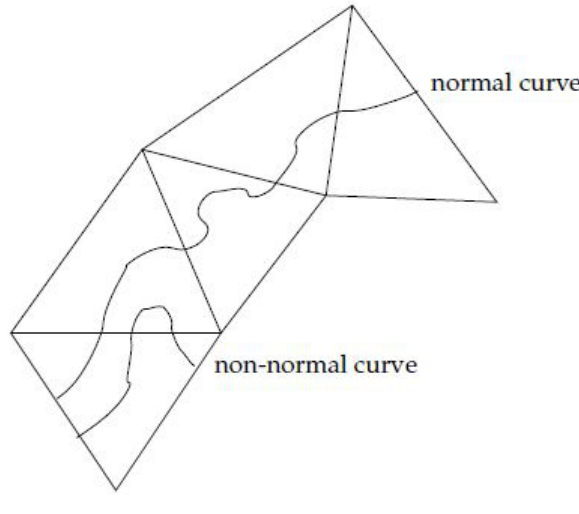
Figure 2. Normal and not normal